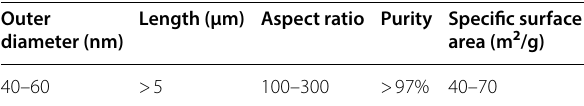
Table 1 Physical parameters of